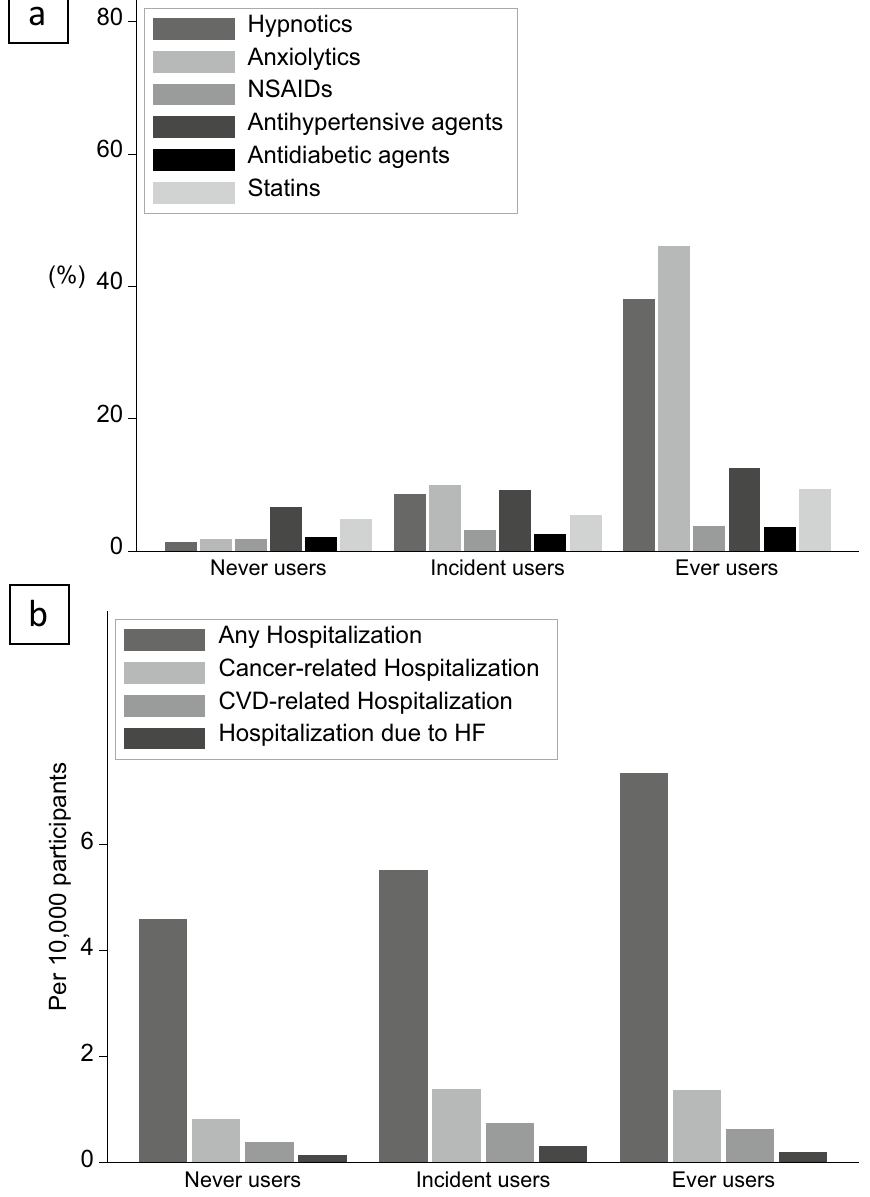
Figure 2. Medication and hospitalization of never, ever, and incident users of antidepressants. NSAIDs non-steroidal anti-inflammatory drugs, CVD cardiovascular disease, HF heart